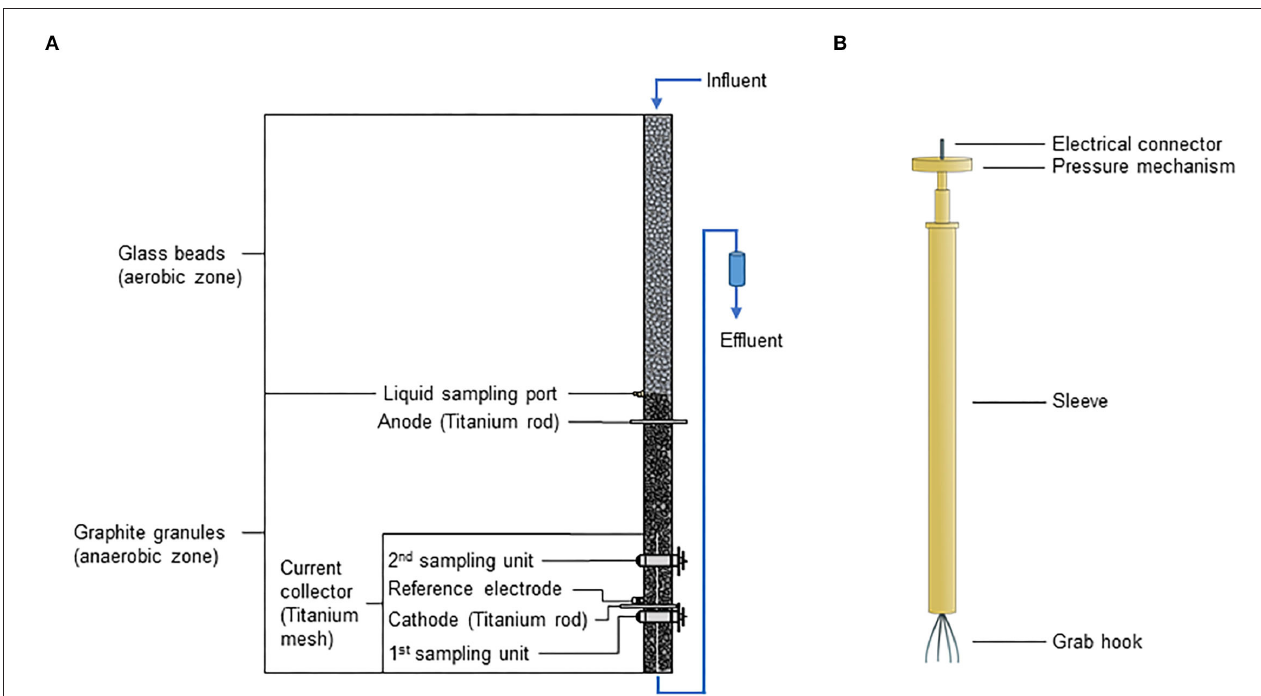
FIGURE 1 | Schematic illustration of (A) electrified biotrickling filters with integrated sampling units and (B) e-clamp. The influent entered the reactor from the top leading to an aerobic zone in the reactor’s upper half (filled with glass beads) enabling aerobic ammonia oxidation. As oxygen was consumed during ammonia oxidation, the lower half of the reactor (filled with graphite granules) became anaerobic allowing bioelectrochemical denitrification at the cathode. A titanium mesh connected to a titanium rod and a single titanium rod were used as cathodic and anodic current collectors, respectively.